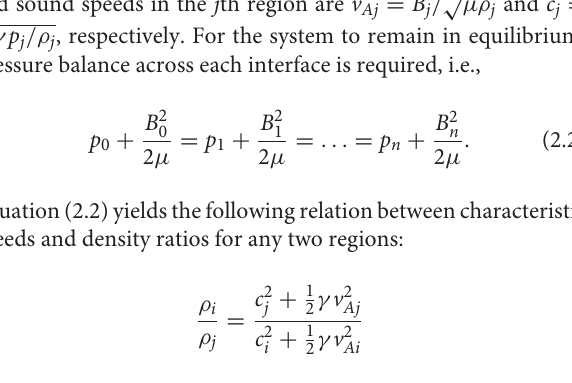
FIGURE 1 | The equilibrium configuration of a layered magnetized plasma. The blue arrows represent the vertical magnetic field, B ( x ) density, ρ j , and temperature, T j are equilibrium parameters. The subscript j corresponds to the relevant slab and varies from 0 to n and sound speeds in the j th region are v Aj